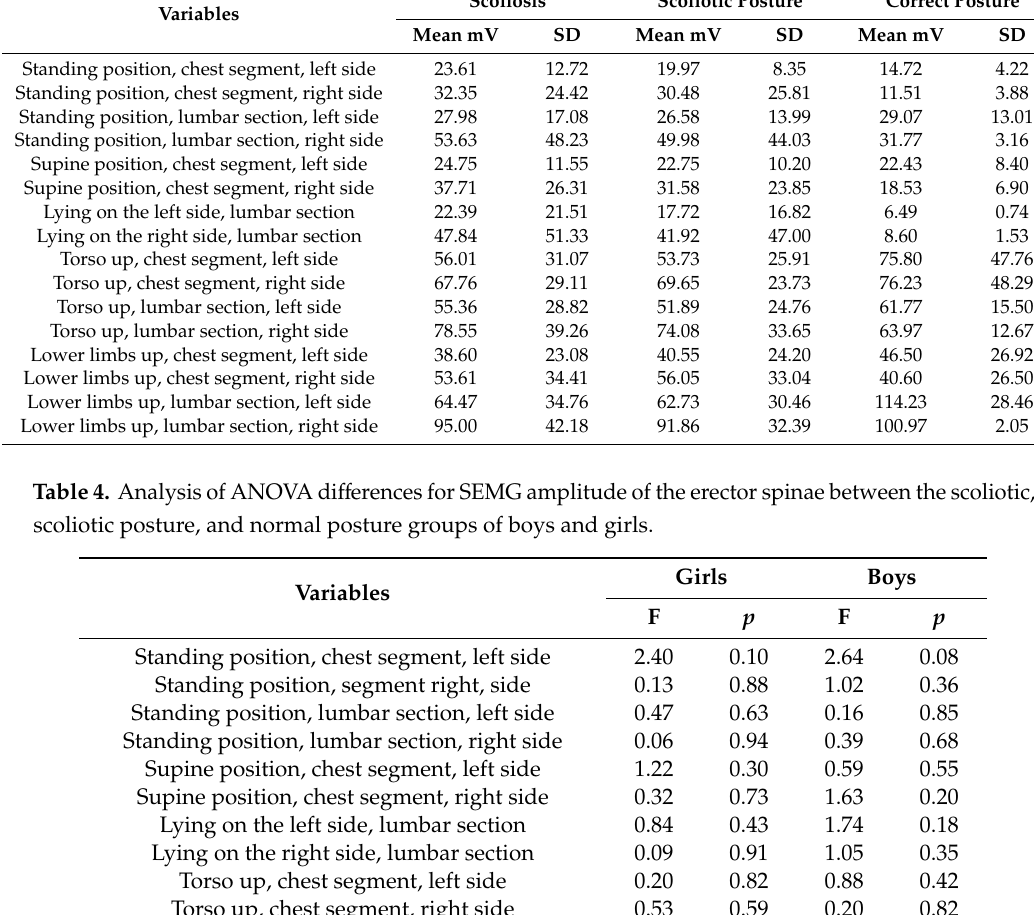
Table 3. SEMG amplitude of the erector spinae in boys. Variables